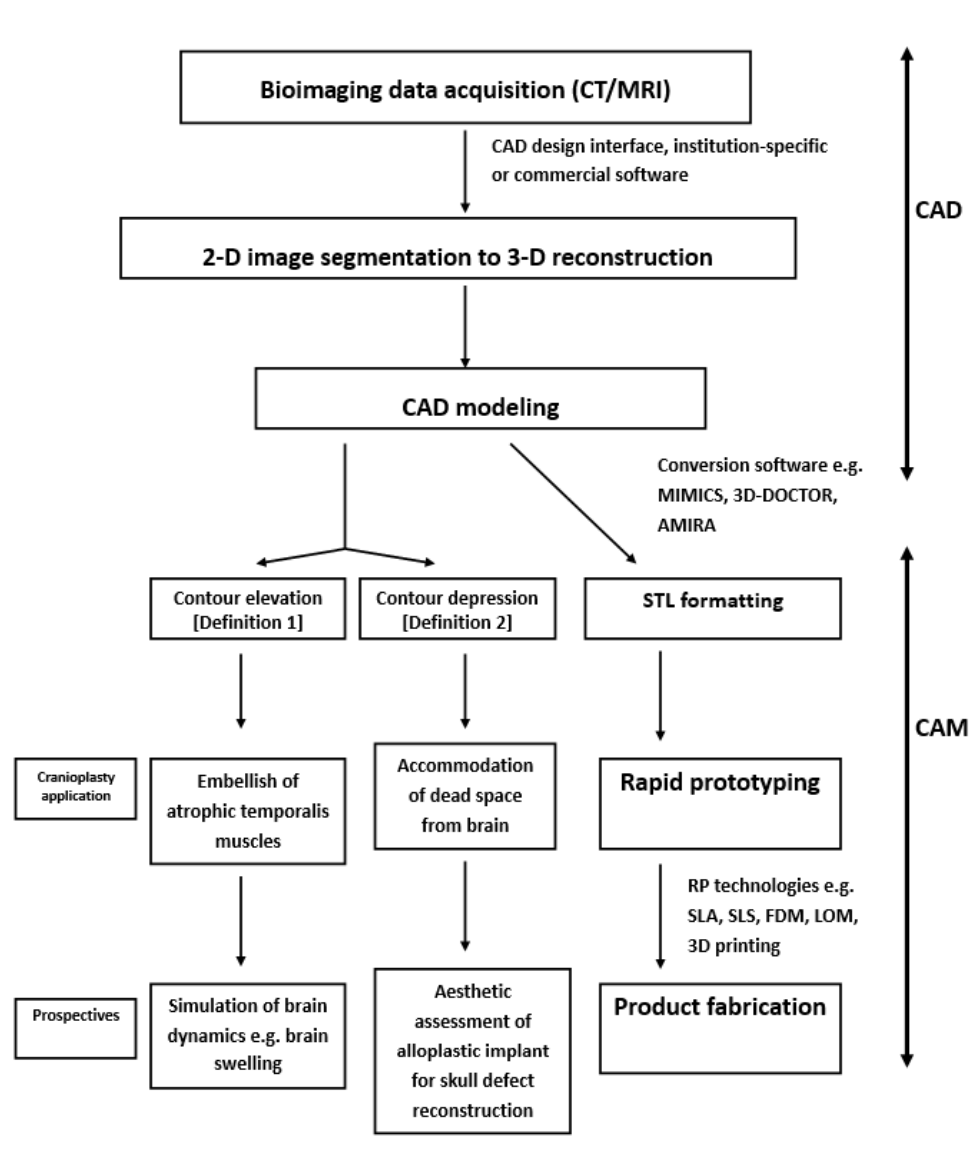
Figure 1. Diagram of computer-assisted design / manufacturing (CAD / CAM) techniques and their potential application in perspective brain sciences.